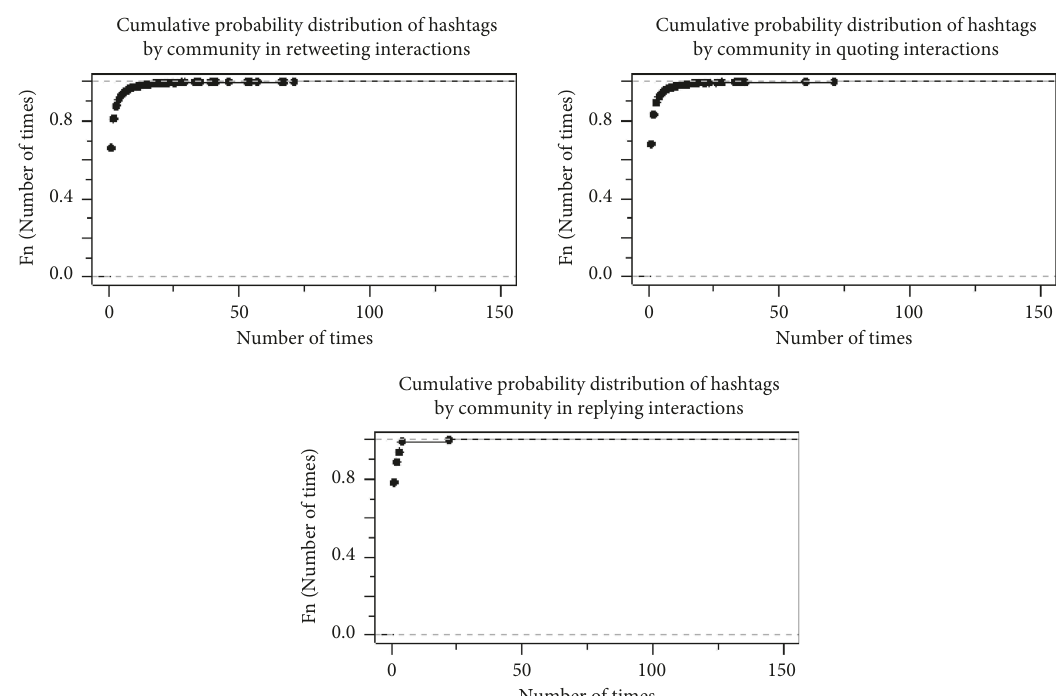
Figure 9: For replying, retweeting, and quoting interactions, cumulative distribution of hashtags by